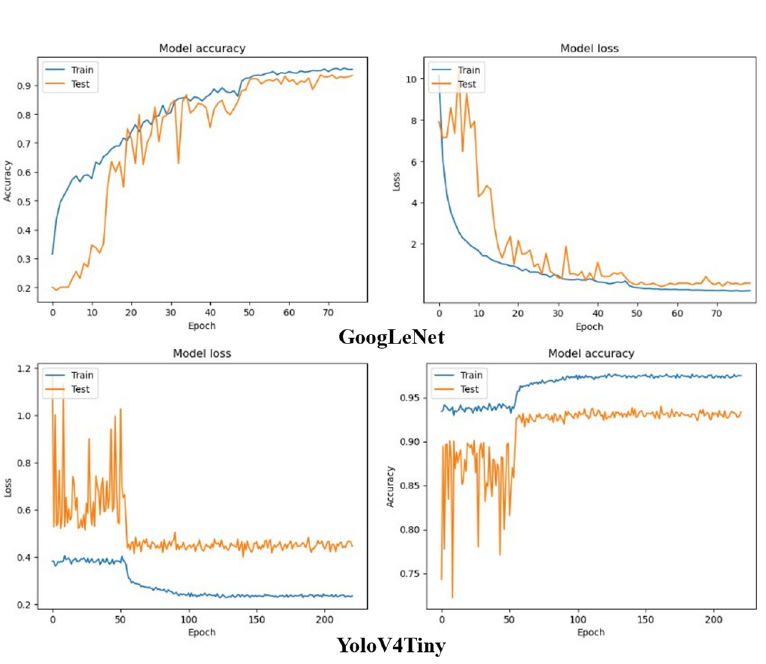
Figure 14. The loss and accuracy curve of the deep-learning network.